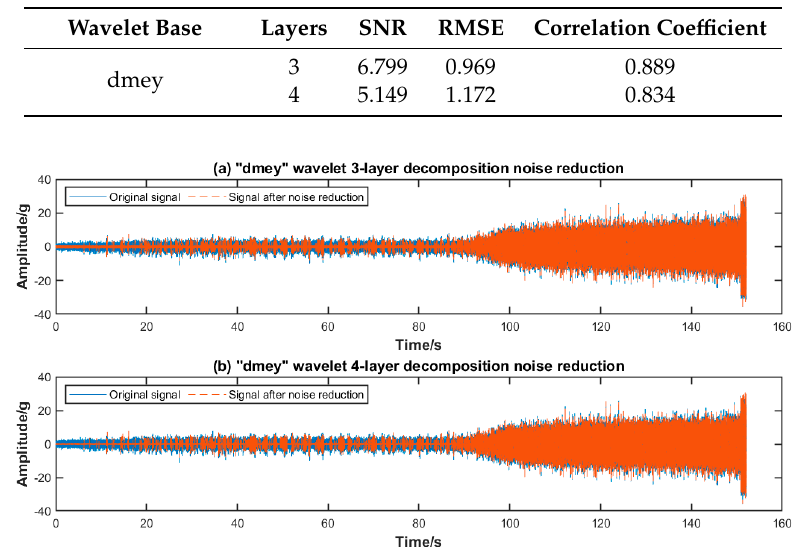
Figure 5. The signal contrast between three and four layers after noise reduction.